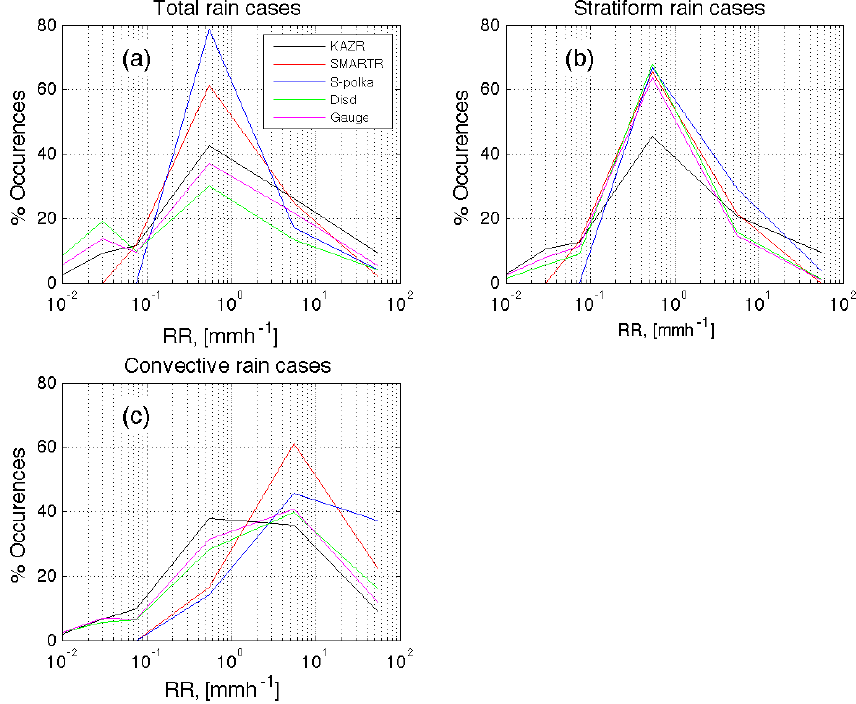
Figure 10. Histograms of rain-rates from the KAZR, SMART-R, S-PolKa, optical rain gauge, and 2-dimensional video disdrometer for (a) total rain cases, (b) stratiform rain cases, and (c) convective rain cases.